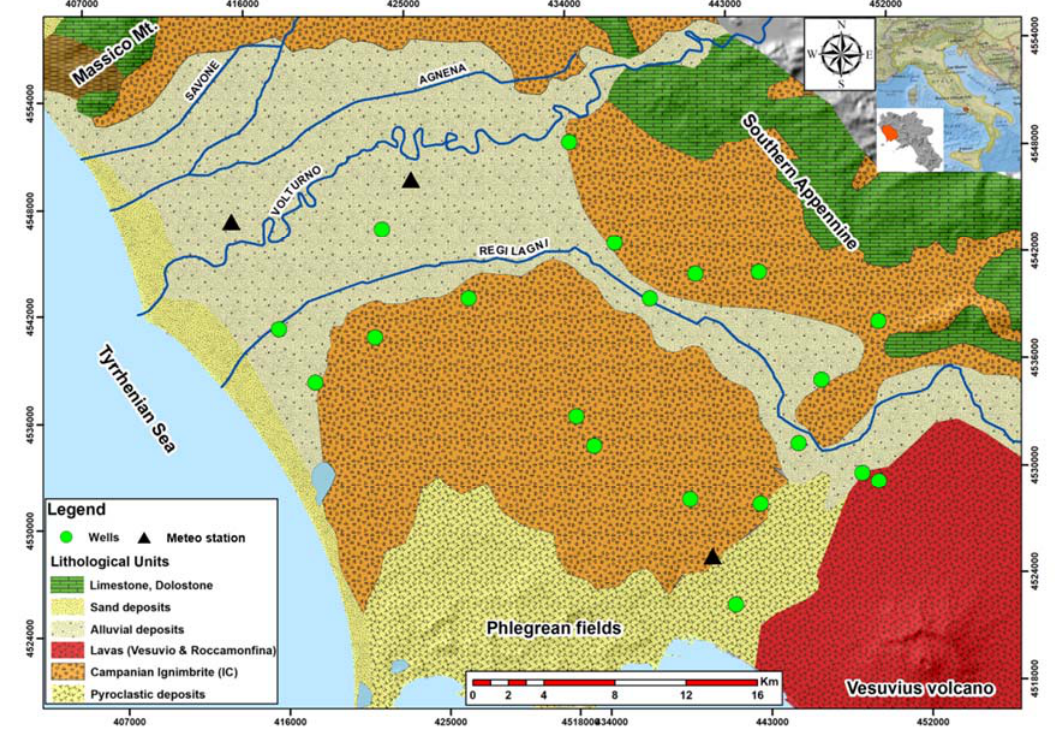
Figure 1. Geolithological map with the location of the monitoring wells and meteorological